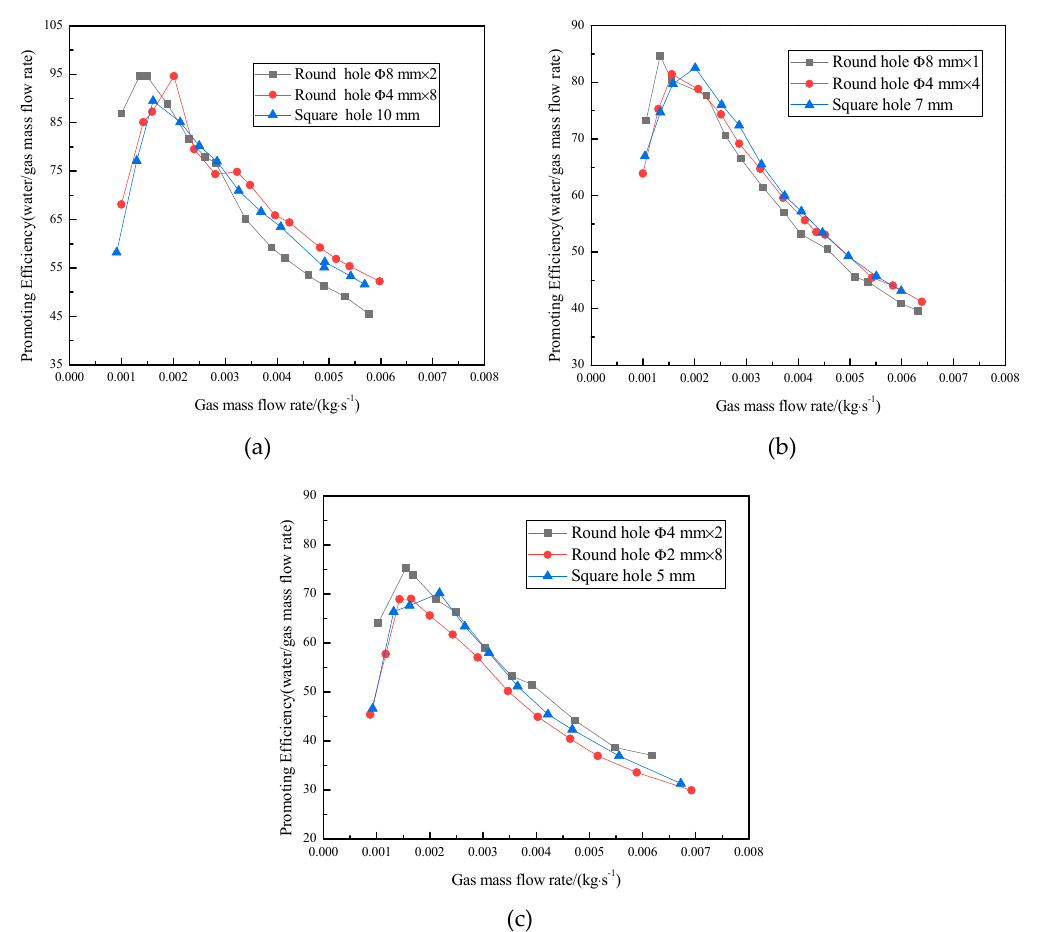
Figure 7. Changes of e ffi ciency of lifting pumps with the same intake areas at submergence ratio of 0.5. ( a ) Intake area of 100 mm 2 ; ( b ) intake area of 50 mm 2 ; ( c ) intake area of 25 mm 2